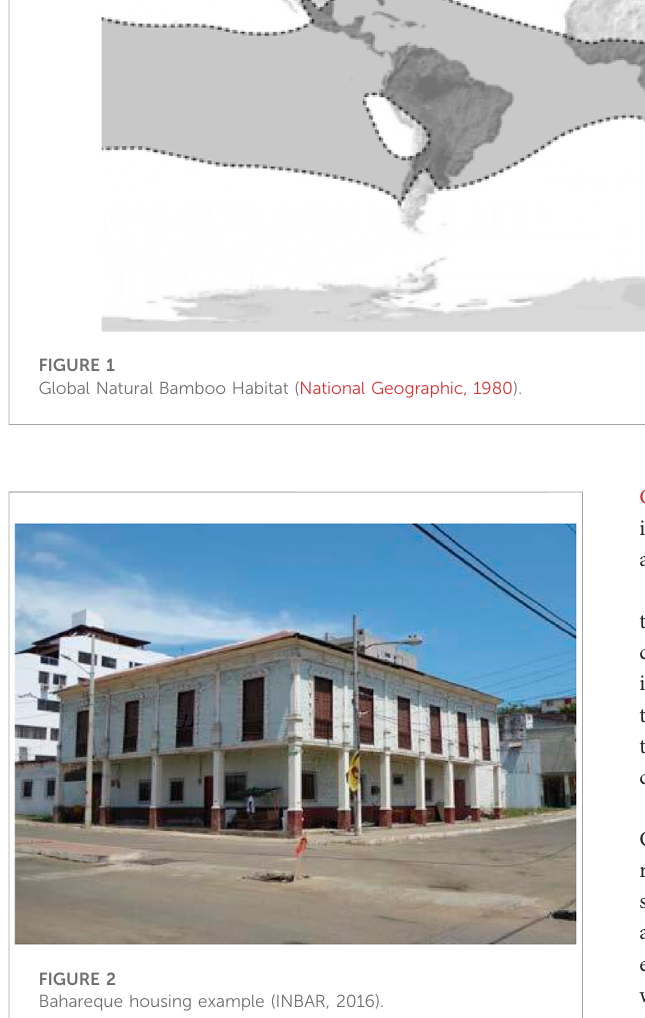
FIGURE 2 Bahareque housing example (INBAR,